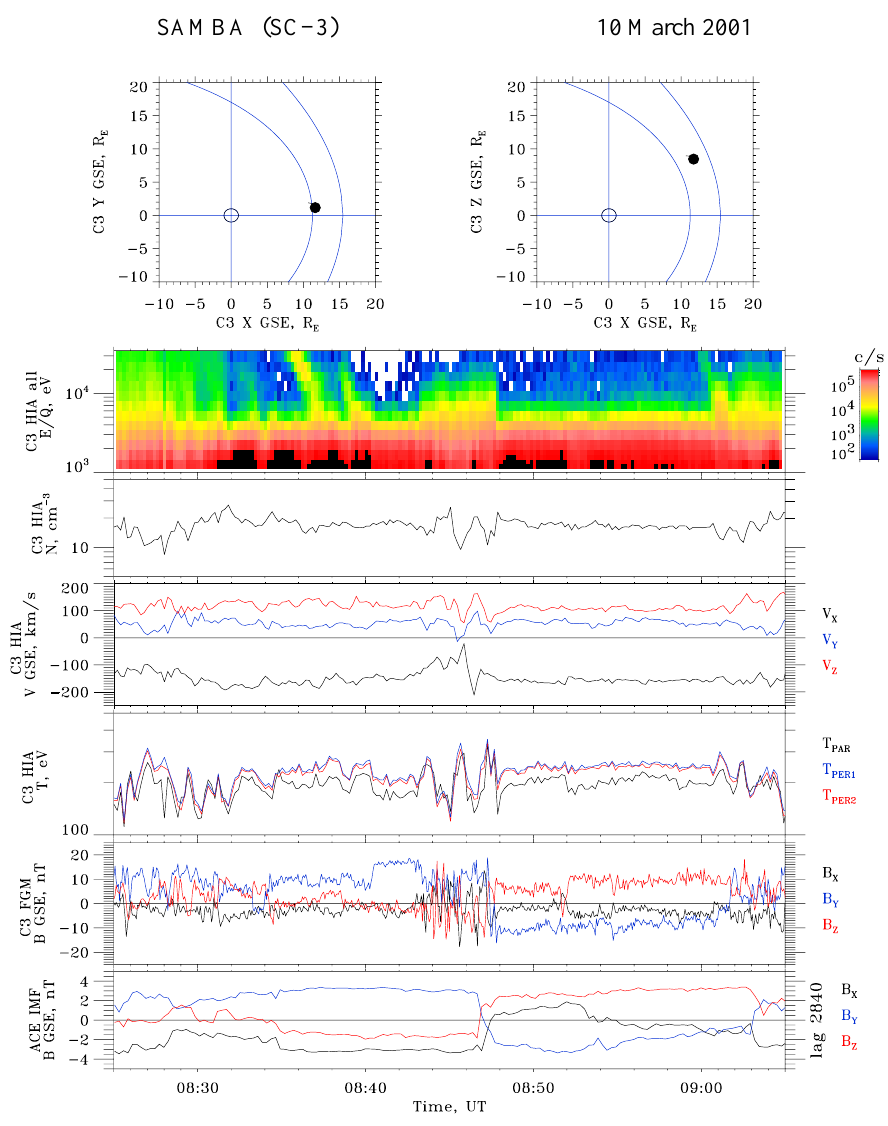
Fig. 1. Example of transient phenomena observed in the magnetosheath by CLUSTER (10 March 2001). The CLUSTER position, the magnetopause and the shock are shown in the two upper plots. Data are presented below, from top to bottom: (1) Energy/time spectrogram from 2 to 30keV measured by CIS, (2) density, (3) plasma velocity, (4) parallel and perpendicular temperatures, (5) magnetic field measured by FGM and, (6) magnetic field measured by ACE far upstream in the solar wind. It is shown with a delay of 2840s.